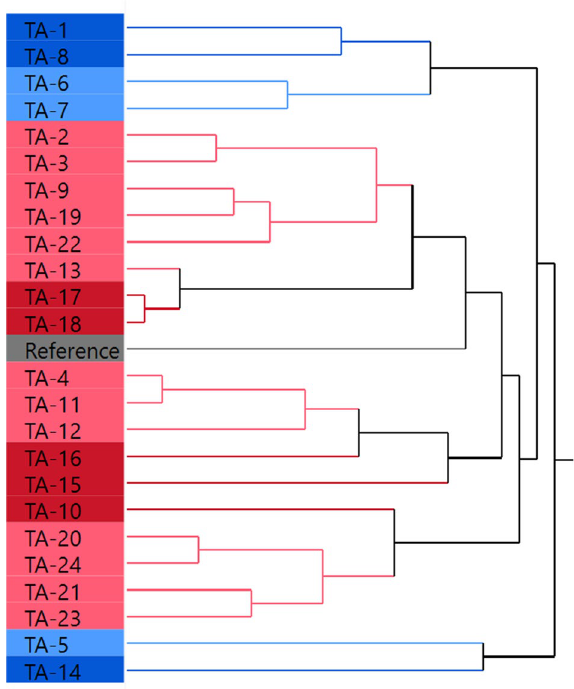
Figure 5. The dendrogram from hierarchical cluster analysis of samples and reference. TA-1 to TA-24 refers to the samples obtained from the designed 24-run experiment in Ambr. FEED B is blue, PFF06 is red, galactose addition day 12 is light color and day 13 is dark color. The image was created by JMP V15 (http:// www. jmp. com).